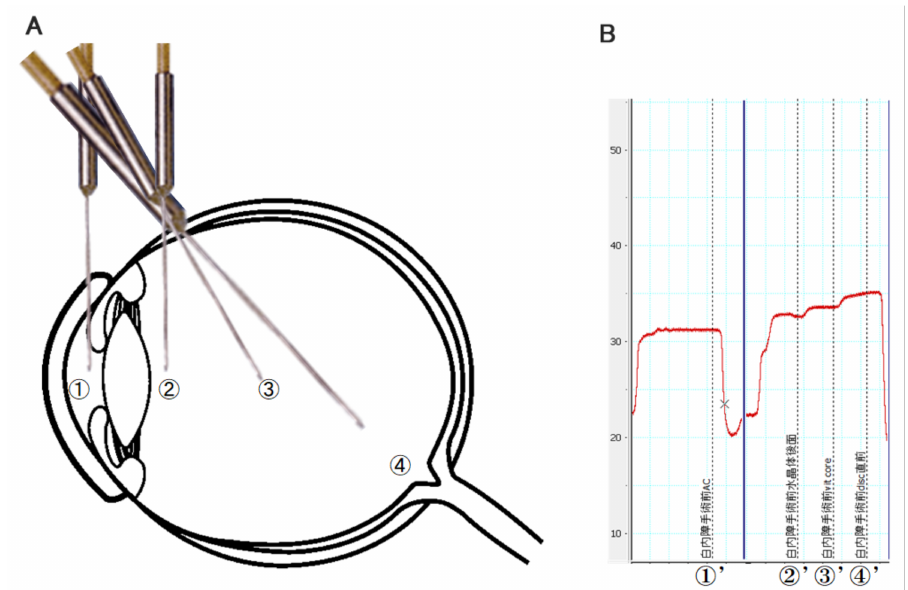
Figure 1. Schematic diagrams of the different intraocular sites for temperature measurements. ( A ) Lo- cation of intraocular temperature measurement using a thermoprobe. The temperature measurements were made by the sensor at the tip of the thermoprobe placed in the anterior chamber (1), behind the lens (2), mid-vitreous (3), and just above the optic disc (4). The thermoprobe was placed while viewing through an operating microscope. ( B ) Measurement of intraocular temperature at different locations at the beginning of the surgery. The tip of the thermoprobe was moved to measure the temperature of each site. The drop in the curve (X) of the temperature indicates that it has dropped to the room temperature because the tip of the thermometer was taken out of the eye. (1) Anterior chamber at the beginning of surgery; (2) behind lens at the beginning of surgery; (3) mid-vitreous at the beginning of surgery; (4) just anterior to the optic disc at the beginning of